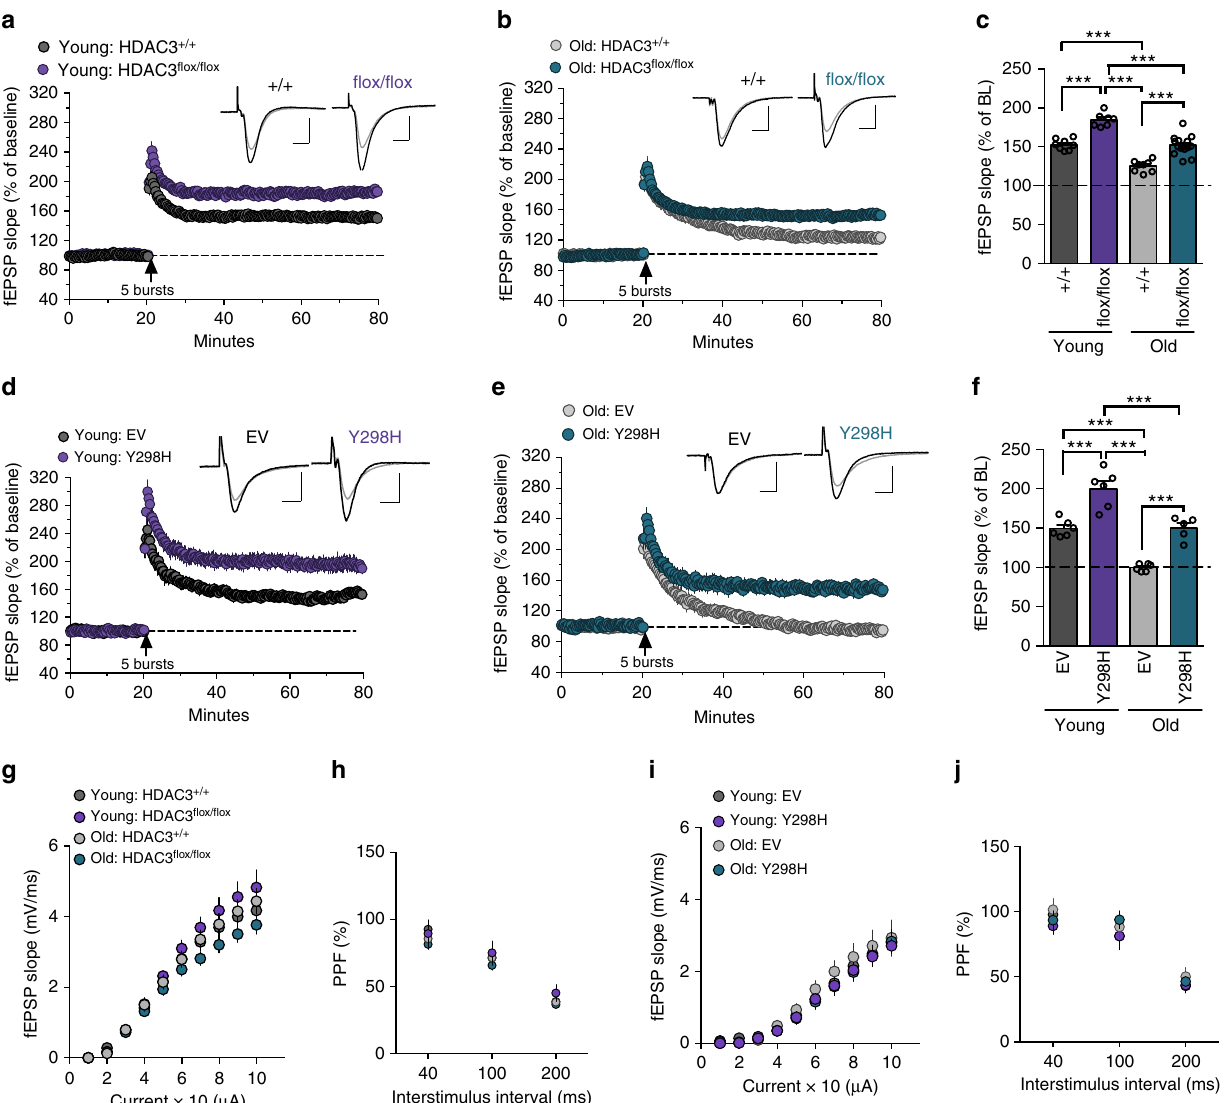
Fig. 2 Deleting or disrupting HDAC3 ameliorates age-related impairments in synaptic plasticity. a Mean ± SEM fEPSP slope recordings in hippocampal slices from young (3-m.o.) HDAC3 fl ox/ fl ox mice or HDAC3 + / + littermates 2-weeks after hippocampal AAV-Cre infusion. Deleting HDAC3 enhanced theta burst-induced LTP in the young hippocampus. Scale bar: 1 mV per 5 ms. b The same stimulation caused a gradual decay toward baseline in slices from old (18-m.o.) HDAC3 + / + mice. Deleting HDAC3 (HDAC3 fl ox/ fl ox ) restored a greater level of stable potentiation relative to HDAC3 + / + littermates. Scale bar: 1 mV per 5 ms. c Summary graph showing mean fEPSP slope 60 m after stimulation. Potentiation was signi fi cantly enhanced by HDAC3 deletion in slices from both young and old mice. Deleting HDAC3 in the 18-m.o. hippocampus produced LTP comparable to that of 3-m.o. wildtype mice (Two-way ANOVA: